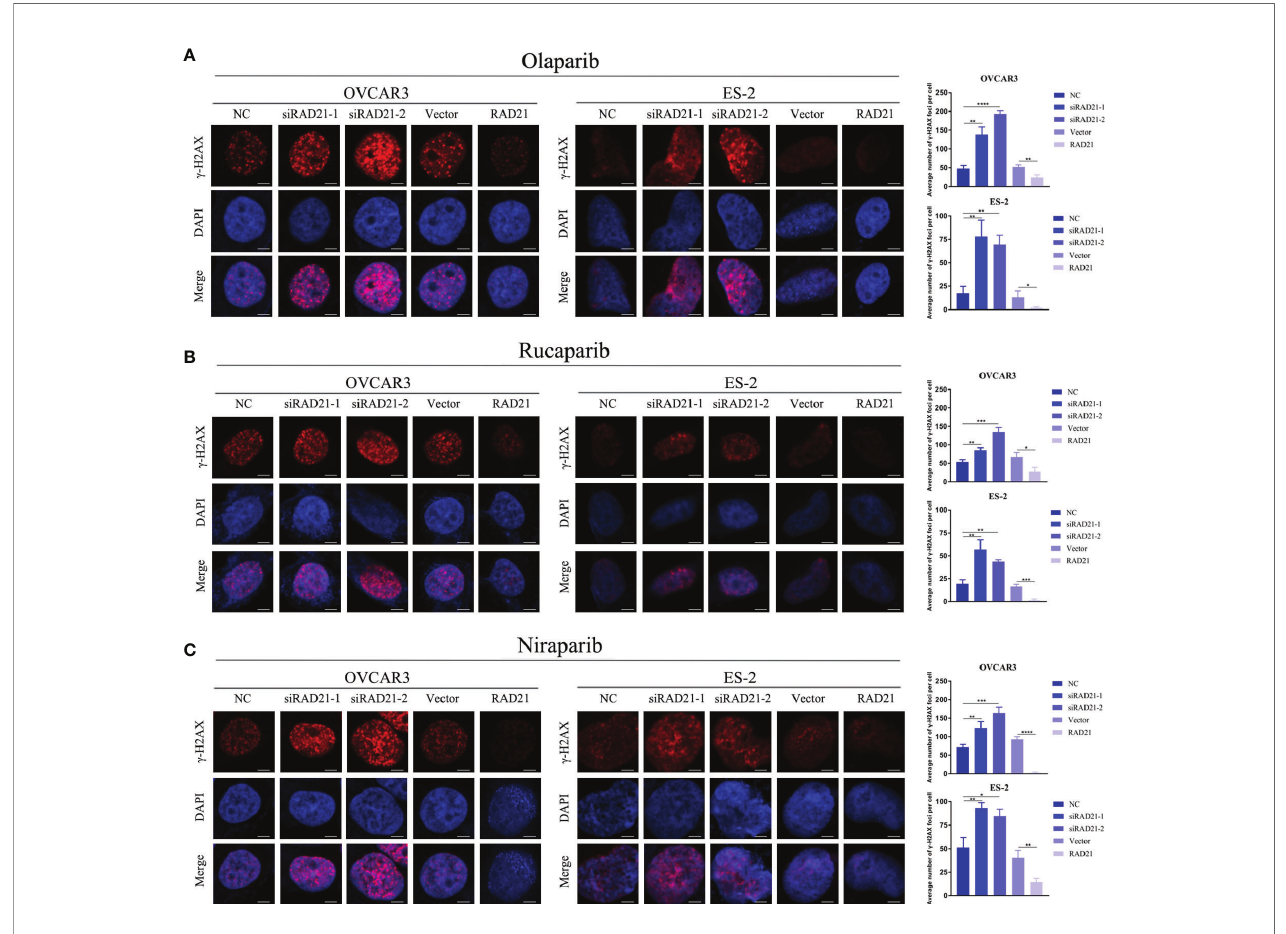
FIGURE 4 | Effects of RAD21 on DSB repair after treatment with poly(ADP-ribose)polymerase (PARP) inhibitors. (A – C) Representative images of immuno fl uorescence staining for g -H2AX and numerical quanti fi cation of g -H2AX foci in ovarian cancer cells treated with olaparib (A) , rucaparib (B) , and niraparib (C) . Scale bar = 10 m m. Data were represented as mean ± SD (n = 3). * p < 0.05; ** p < 0.01; *** p < 0.001; **** p <